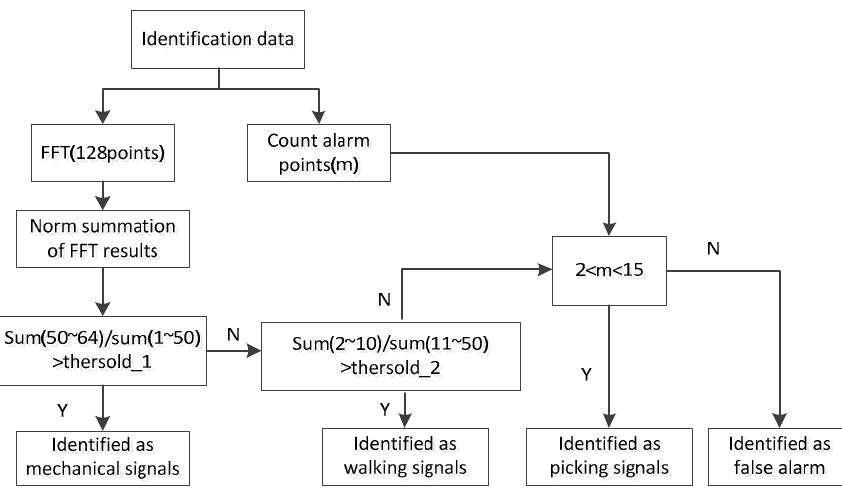
Figure 5. Feature extraction and identification.